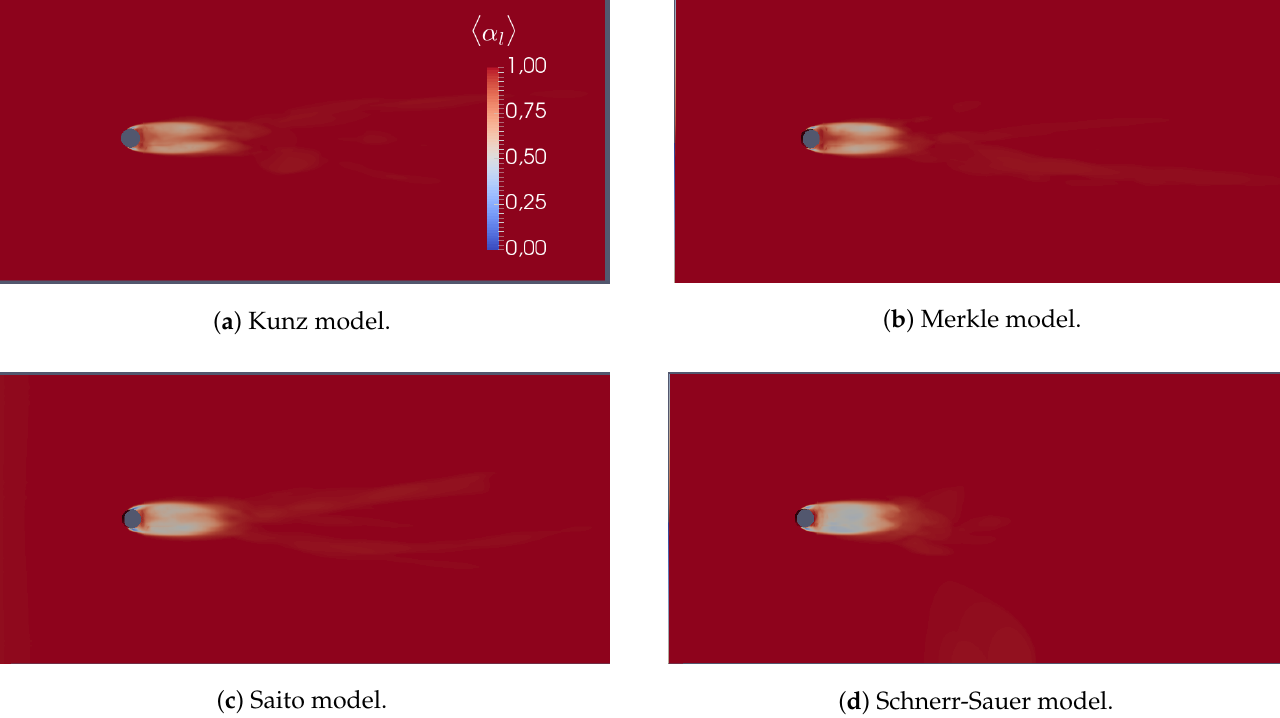
Figure 17. Contour of time-averaged liquid fraction, results obtained considering analytical-based